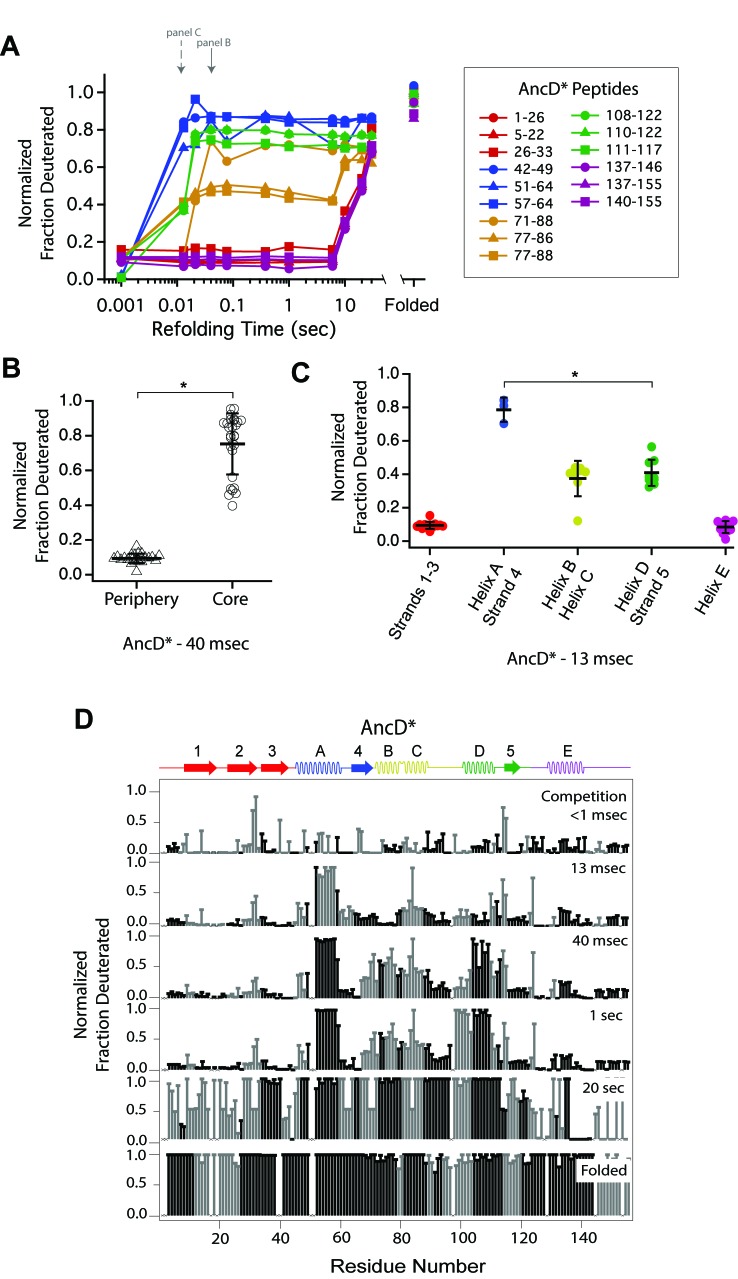
Determination of the folding pathway of AncD* by HX-MS.(A) Protection of representative peptides from AncD* at various refolding times. Peptides are colored according to their corresponding structural element. The solid arrow indicates the refolding time point analyzed in panel B. The dotted arrow indicates the refolding time point analyzed in panel C. (B) Protection of peptides mapping to the core region (Icore) or the periphery region of AncD* at 40 msec after refolding. Bars represent the mean and standard deviation of each data set. *p<0.0001 (Welch’s unpaired T-test) (C) Protection of peptides of AncD* mapping to distinct secondary structural elements at 13 msec after refolding. Bars represent the mean and standard deviation of each data set. *p=0.021 (Welch’s unpaired T-test). Data for B and C represent aggregate data from three separate experiments. (D) Residue-resolved folding pathway of AncD* at representative refolding time points. Data points in black indicate residues that are site-resolved. Data points in grey indicate residues in regions with less peptide coverage and are thus not site-resolved with the neighboring residues. Residues where site-resolved protection could not be determined due to insufficient peptide coverage is denoted with a ‘x’.